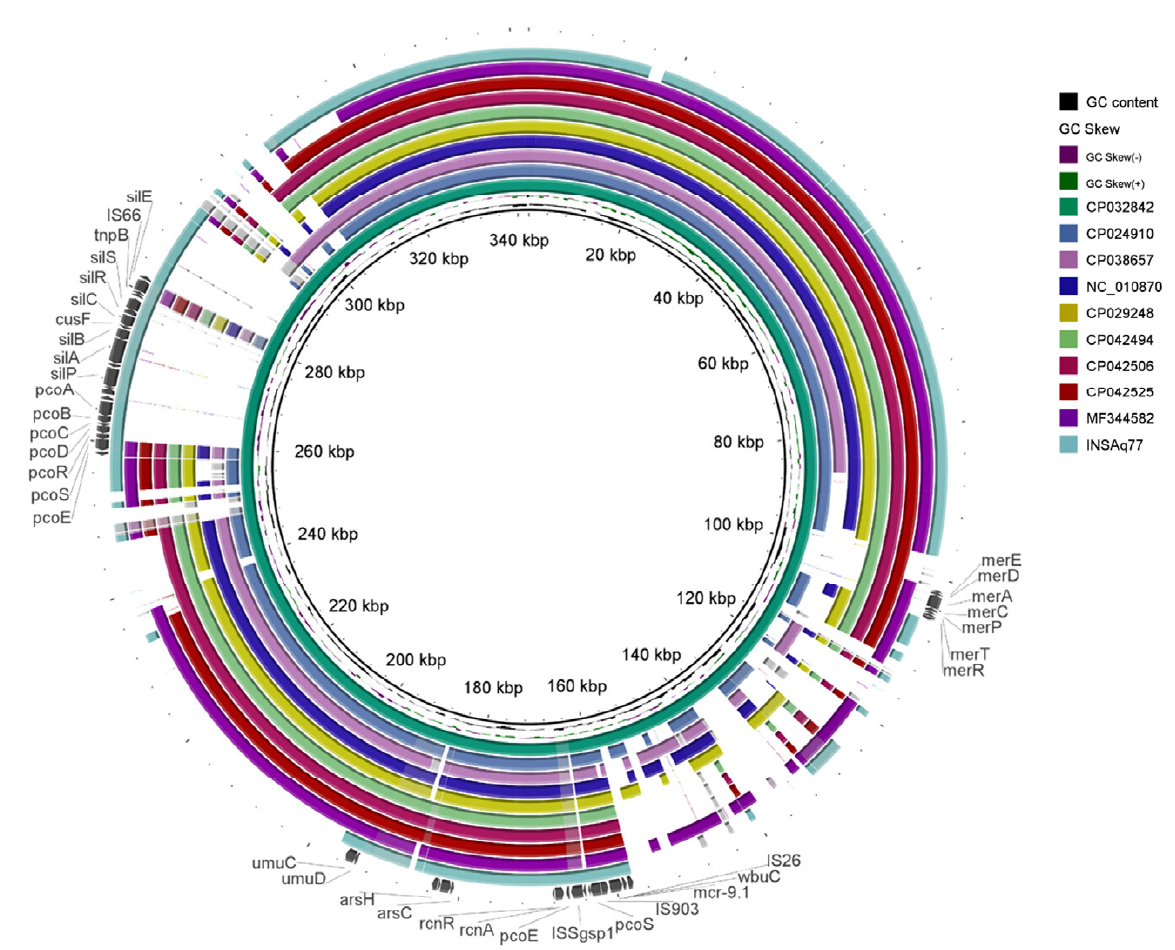
Figure 3. Comparative analysis of INSAq77 mcr-9.1 -containing contig with nine closely related IncHI2 mcr-9 -harboring plasmids using the BLAST Ring Image Generator.